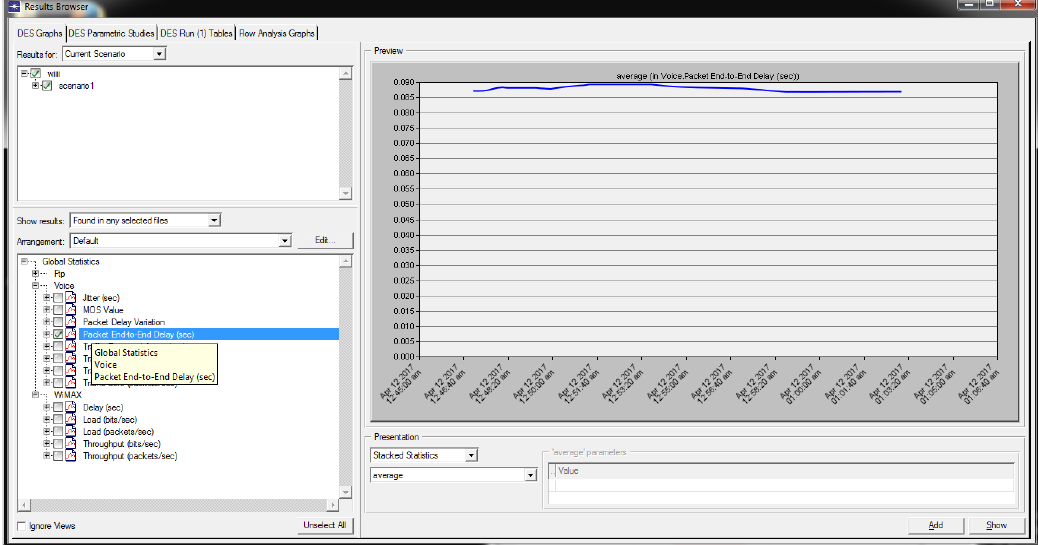
Fig. 9. This record of delay doesn’t slowdown the